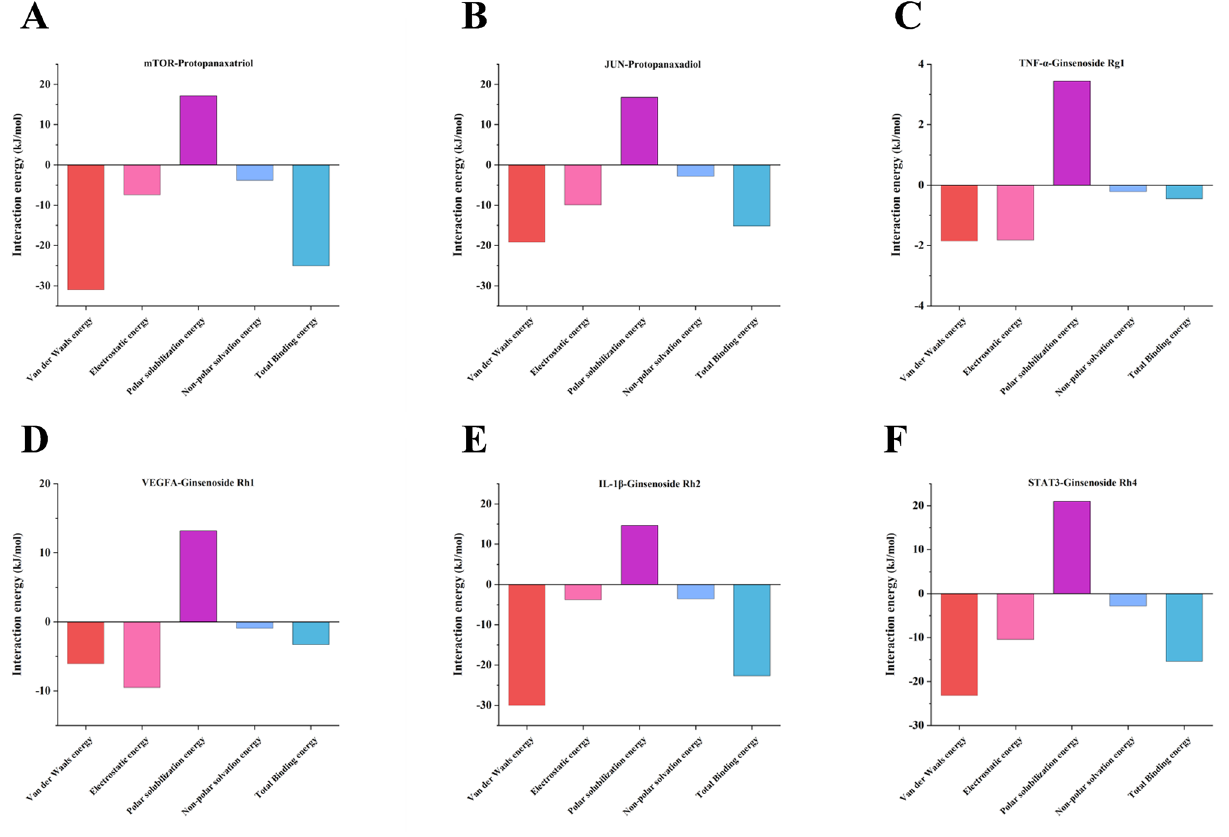
Figure 9. Analysis of the free energy sources involved in the binding of proteins to molecules during molecular dynamics